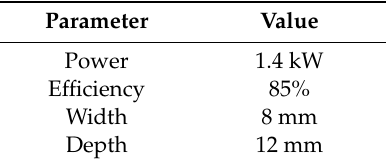
Table 2. Parameters of the heat source for subsequent heating.